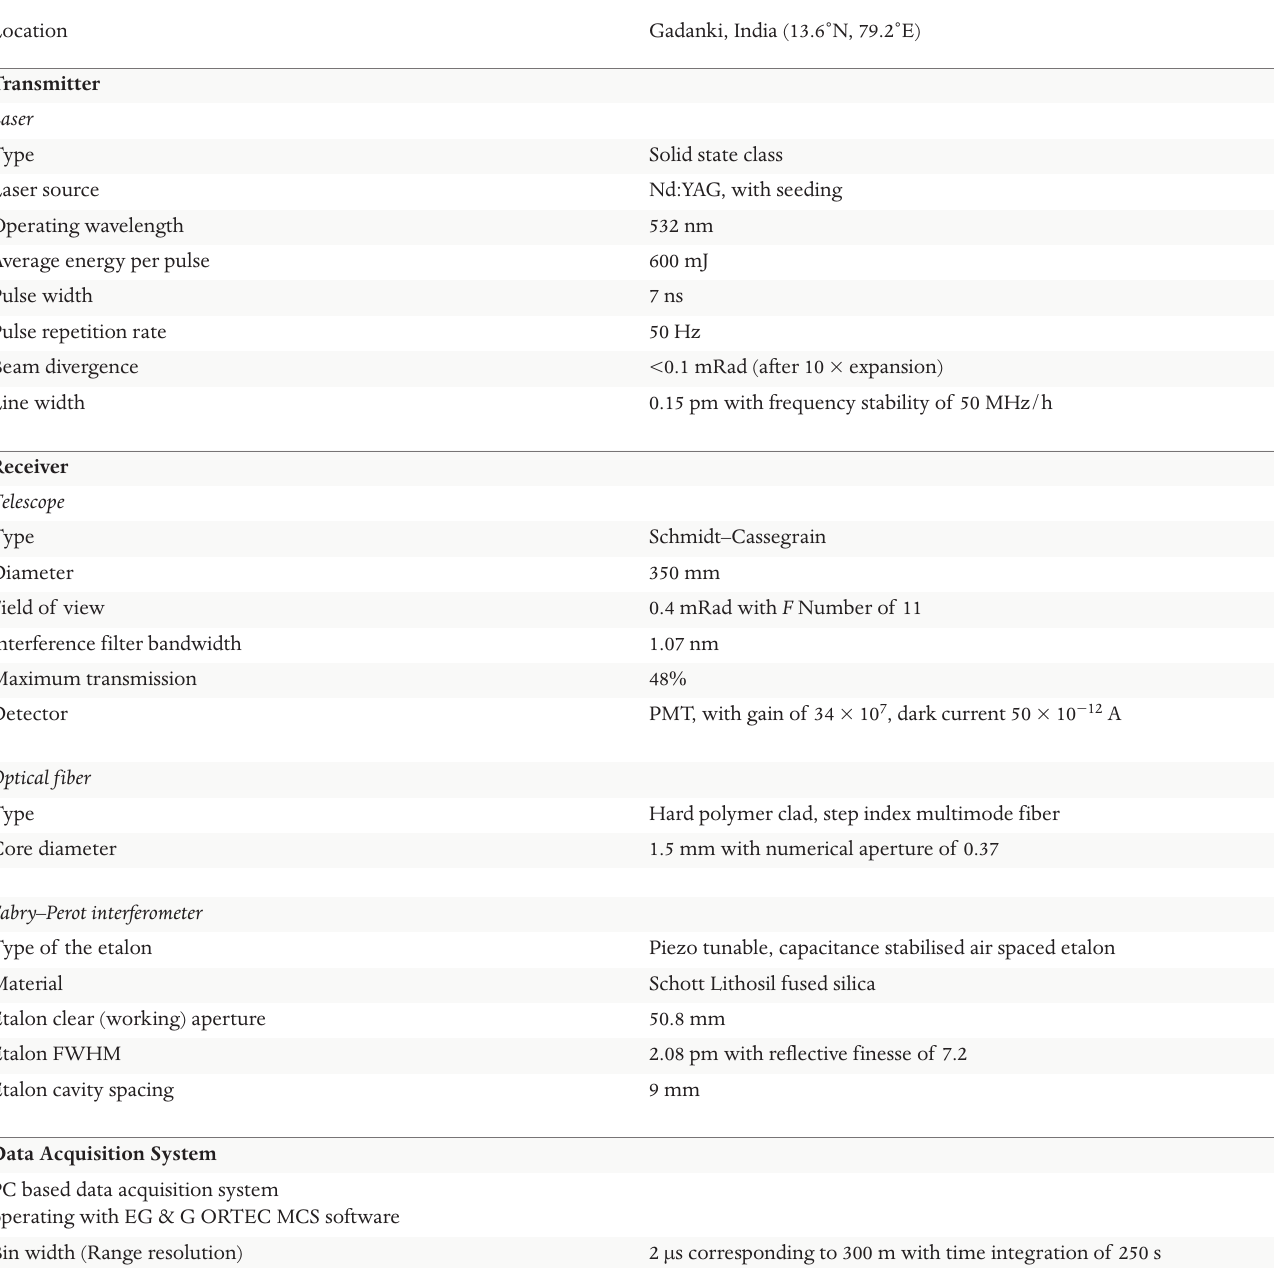
Table 1. Specifications of the